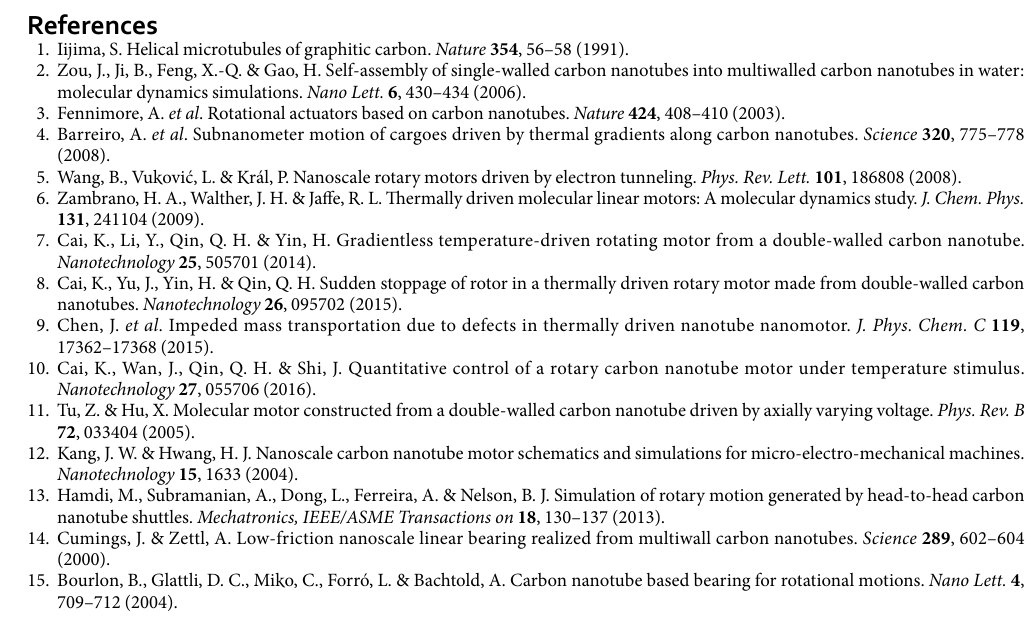
(1) For a short nanobearing, a long inner tube can rotate in stable state in the middle tube when the radius difference between them is smaller than 0.34 nm. In this case the inner tube may escape from the Rotor2 with larger rotational frequency ( ω 2 ); (2) There is a critical value of rotational frequency of Rotor2 at which Rotor1 can escape from Rotor2. In other words, escape happens once ω 2 is larger than the critical value. The peak value of ω 1 is obviously smaller than ω 2 ; (3) Generally, the higher radius difference between both rotors leads to shorter time for Rotor1 to escape from Rotor2; (4) For the same radius difference ( > 0.34 nm) between the two rotors, Rotor1 needs longer time to escape from the Rotor2 with the same length but smaller radius.